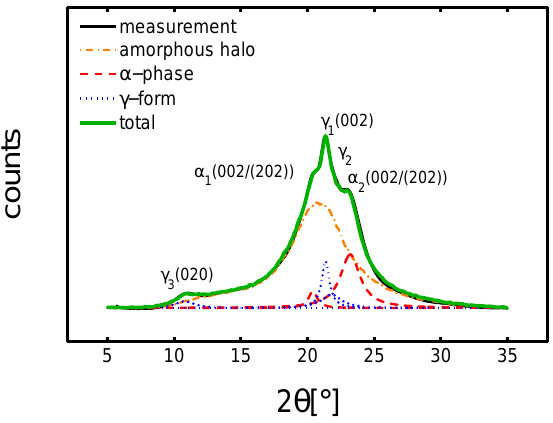
Figure 1. Example of wide angle x-ray diffraction (WAXD) pattern deconvolution analysis. The green line is the result of the deconvolution procedure, the orange line is the measured amorphous halo, and blue and red curves are the Lorentzian